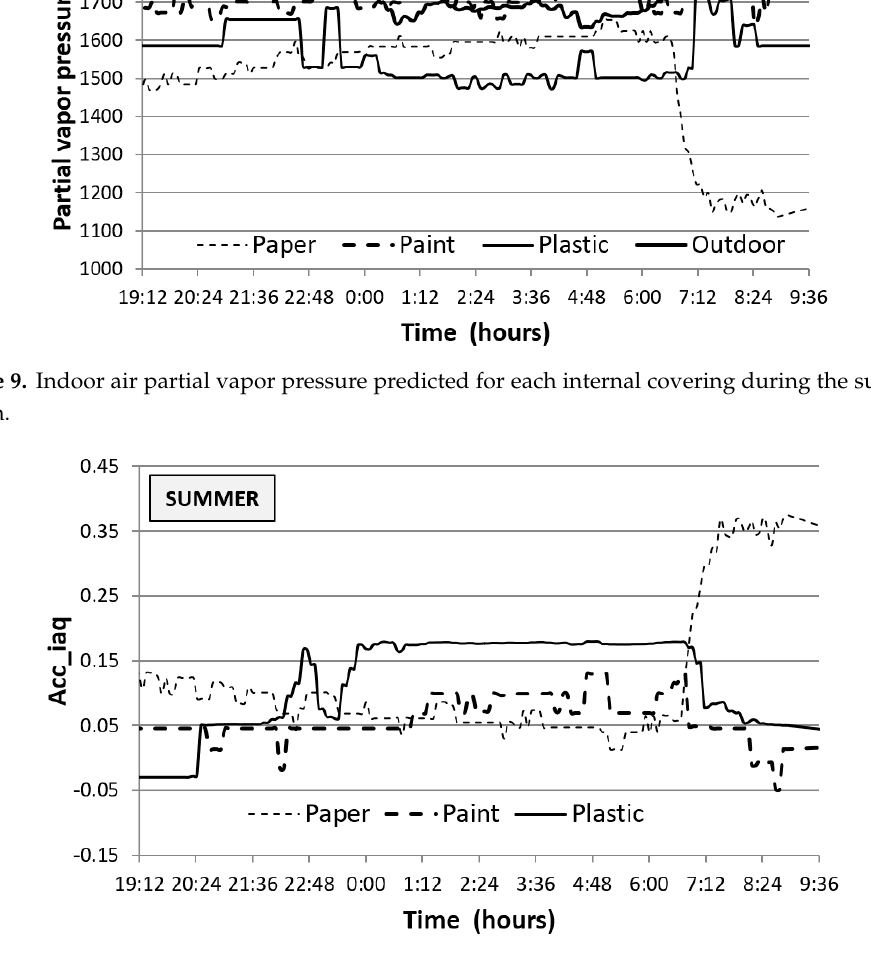
Figure 11. Indoor air percentage of dissatisfied persons (PD IAQ ) predicted for each internal covering during the summer season. Figure 12. Indoor air enthalpy predicted for each internal covering during the summer season.